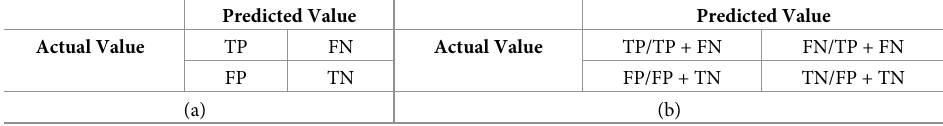
Table 3. The confusion matrices; (a) without normalization and (b)